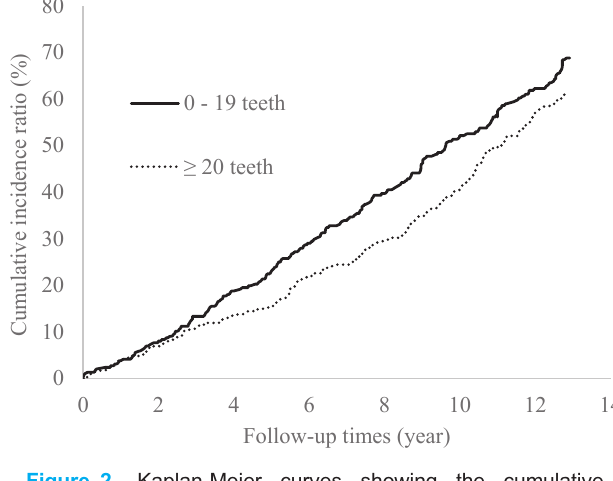
Figure 2. Kaplan-Meier curves showing the cumulative incidences of functional disability according to the number of remaining teeth after propensity score matching. Log-rank test, P = 0.03